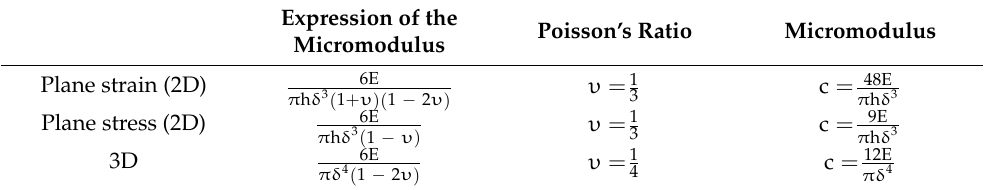
Table 1. Micromodulus c in